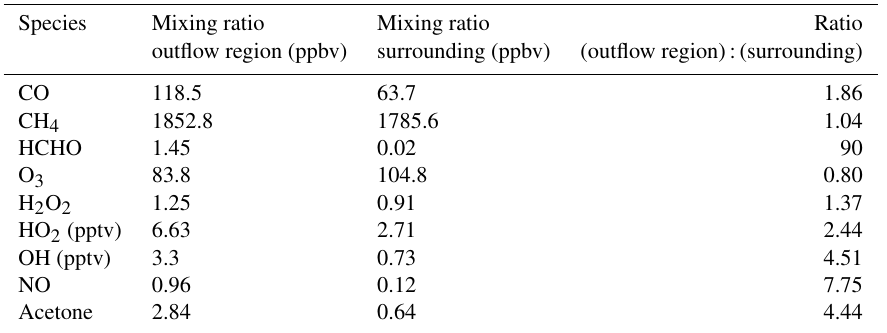
Table 1. Median mixing ratios of different species in the outflow region of the thunderstorm cloud and its surroundings, including the enhancement ratios.